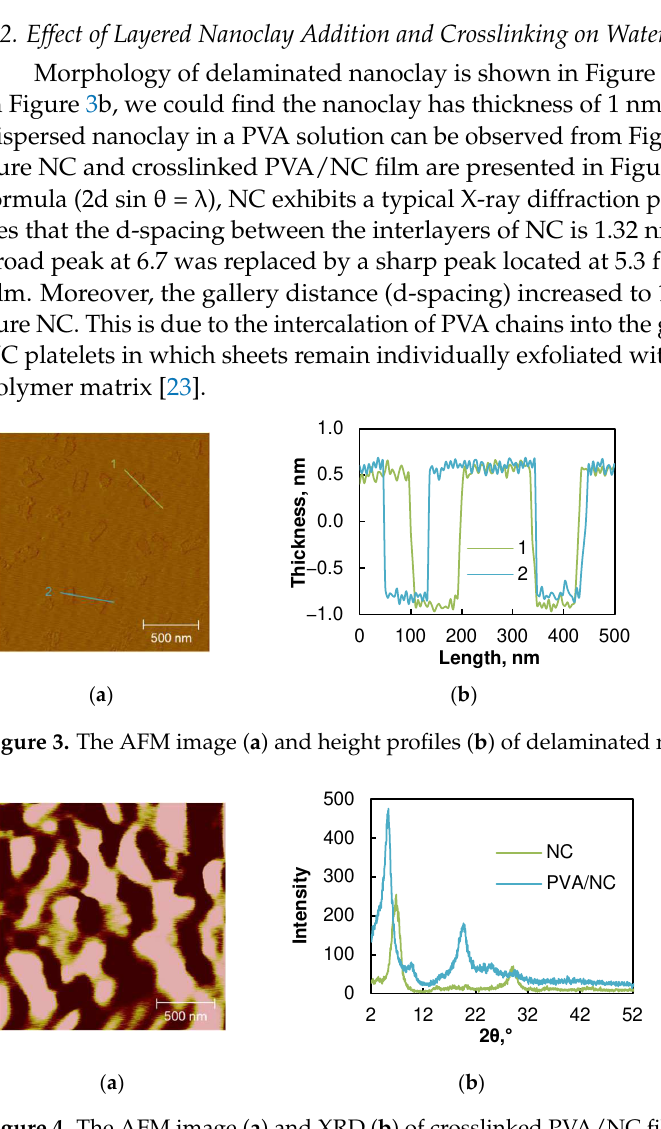
Figure 2. The WVTR of PVA and PVA gel coated paper at different temperatures and humidity. ( a ) 23 °C, 50% RH, ( b ) 38 °C, 90% RH.